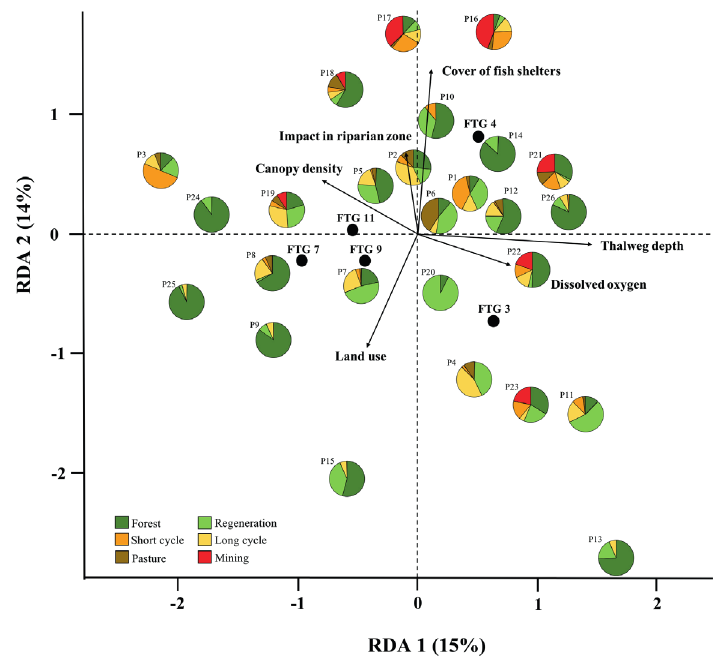
FIGURE 3 | Relationships between fish functional trophic groups and environmental variables (land use and local habitat) in the streams evaluated in this study. The groups are represented by the labels: Diurnal channel drift feeders (FTG 3), Diurnal backwater drift feeders (FTG 4), Diurnal surface pickers (FTG 7), Diggers (FTG 9) and Ambush and stalking predators (FTG 11). The FTG’s with a correlation between 0.2 and -0.2 have been omitted for better visualization of the results.